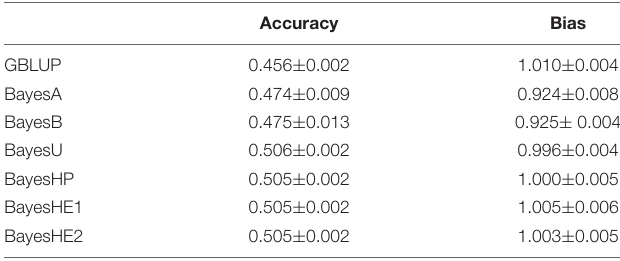
TABLE 1 | Prediction accuracies and biases of DGVs of test dataset from 15th QTL-MAS data using six-fold cross-validation with five replications. Accuracy